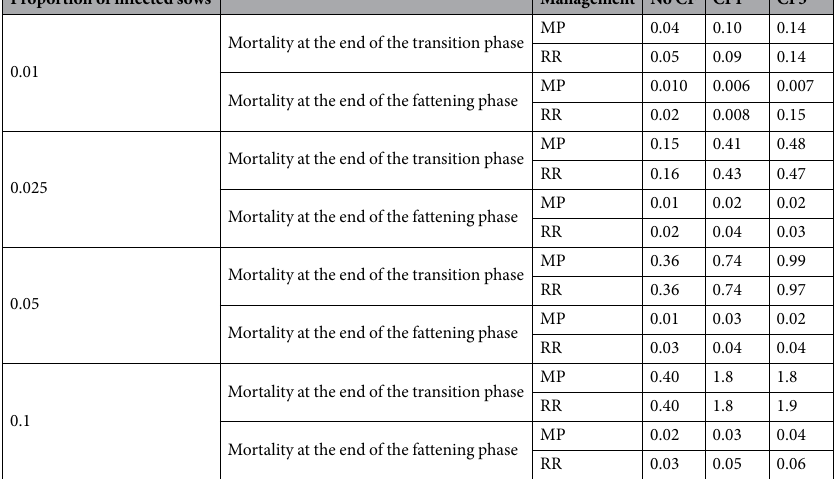
Table 3. Mortality (%) in nursery and fattening taking into account cross-fostering and management procedures. Mortality is calculated as the percentage of dead animals versus the whole population during one period. CF means cross-fostering. Management refers to orderly or random movements during transition and fattening. CF1 and CF3 means that cross-fostering is carried out one or three times during the lactation period. MP means orderly movements consisting of filling the pens during transition according to the sow’s origin and during fattening according to nursery distribution whereas RR means movements consisting of filling the nursery and fattening pens at random.